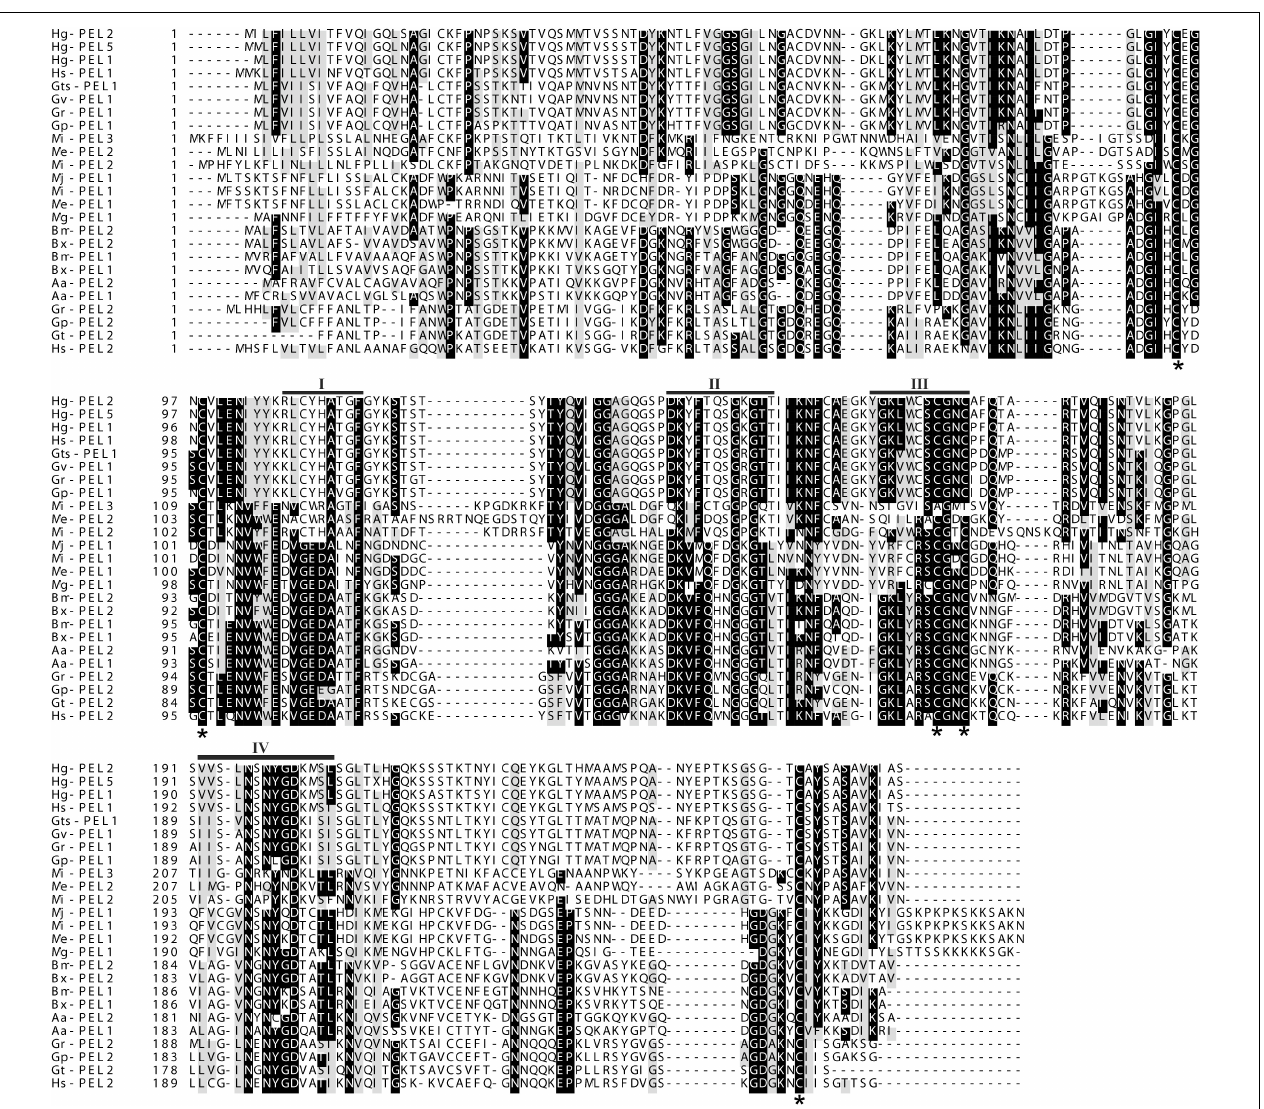
FIGURE 1 | Multiple sequence alignment of the predicted Mg-PEL1 protein with other pectate lyase sequences from plant-parasitic nematodes. Hg-PEL2 (AAM74954), Hg-PEL5 (ADW77536), and Hg-PEL1 (AAK08974) from Heterodera glycines ; Hs-PEL1 (ABN14273) and Hs-PEL2 (ABN14272) from H. schachtii ; Gts-PEL1 (AEA08834) and Gt-PEL2 (ACU64859) from Globodera tabacum ; Gv-PEL1 (AEA08828) from G. virginiae ; Gr-PEL1 (AAF80746) and Gr-PEL2 (AAM21970) from G. rostochiensis ; Gp-PEL2 (ACU64845) and Gp-PEL1 (AEA08862) from G. pallida ; Mi-PEL1 (AAQ09004), Mi-PEL2 (AAQ97032) and Mi-PEL3 (AAW56829) from Meloidogyne incognita ; Me-PEL1 (ADN87334) and Me-PEL2 (ALB38961) from M. enterolobii ; Mj-PEL1 (AAL66022) from M. javanica ; Mg-PEL1 (MW266124) from M. graminicola ; Bm-PEL1 (BAE48374) and Bm-PEL2 (BAE48375) from Bursaphelenchus mucronatus ; Bx-PEL1 (BAE48371) and Bx-PEL2 (BAE48372) from B. xylophilus ; Aa-PEL1 (BAI44499) and Aa-PEL2 (BAI44497) from Aphelenchus avenae . Black bars (I–IV) indicate the conserved regions. Black stars indicate the conserved cysteine